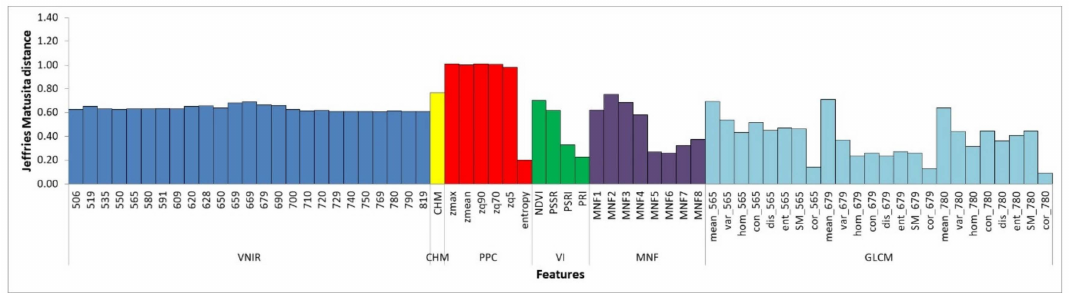
Figure 4. Je ff ries–Matusita distance mean among all classes according to each